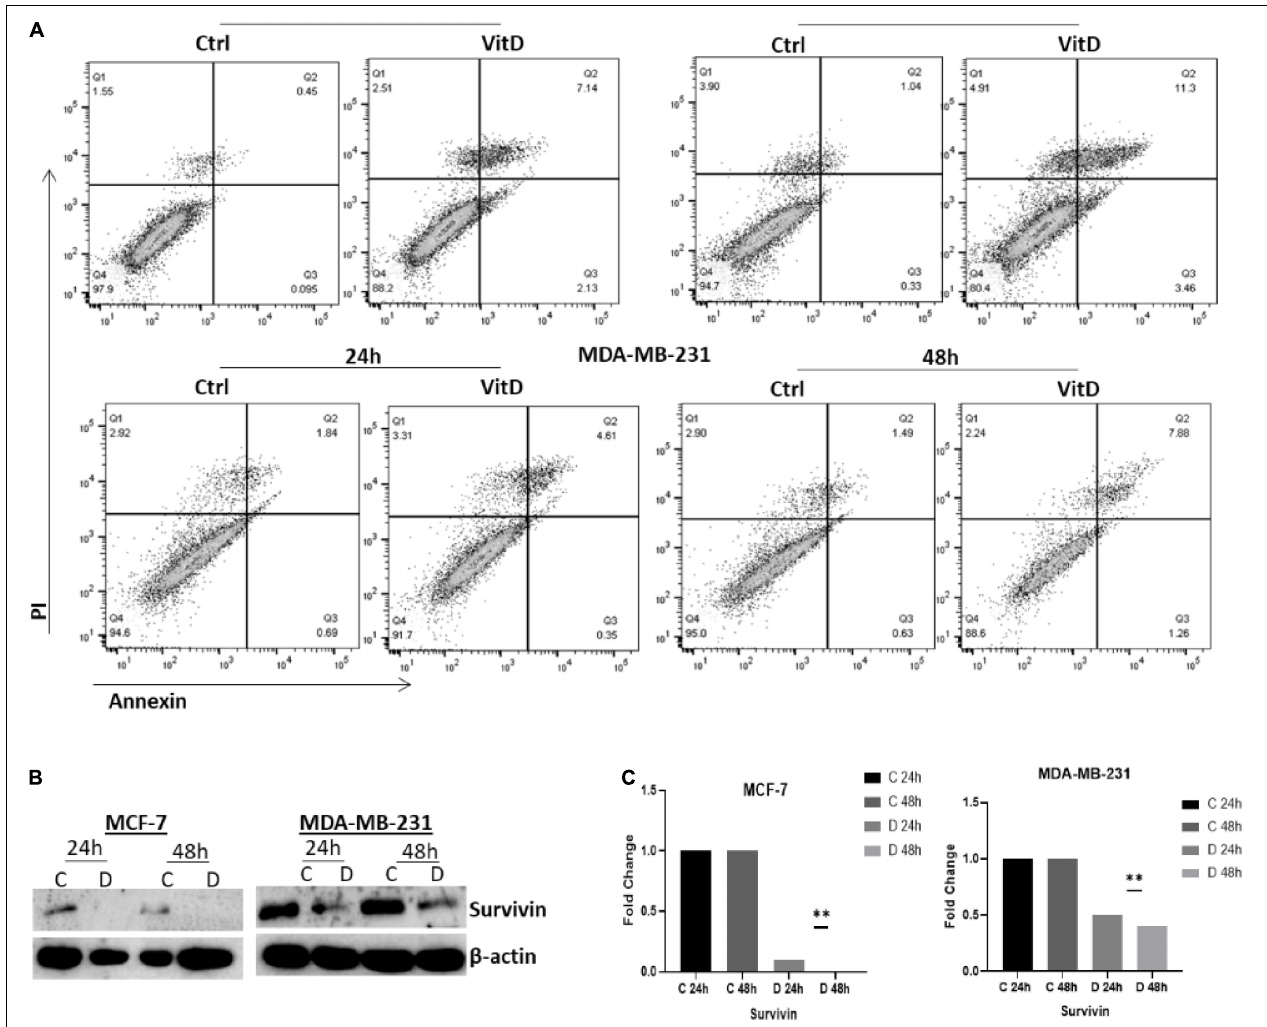
FIGURE 8 | Vitamin D effect on apoptosis and cell survival in BRCA cells. (A) The Annexin V/PI flow cytometry-based method used to assess the percentage of apoptotic and pro-apoptotic in MCF-7 and MDA-MB-231 cells treated with 10 µ M of vitamin D for 24 or 48 h. (B) Survivin expression was assessed in 10 µ M of vitamin D-treated cell lysates and from untreated controls at 24 and 48 h post-culture. (C) Quantitative analysis of relative protein band density after normalization to β -actin and compared to the control. **Represents statistically significant change ( P <